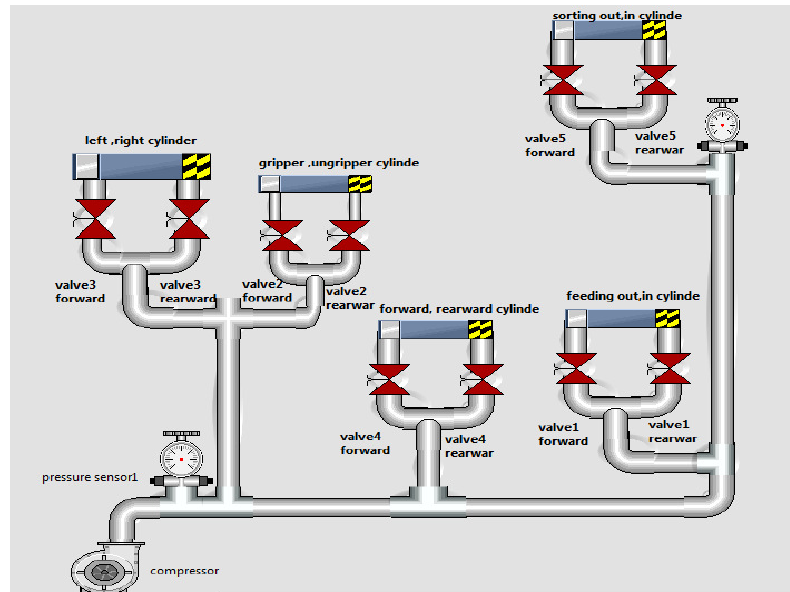
Fig. 14. HMI in PC screen .